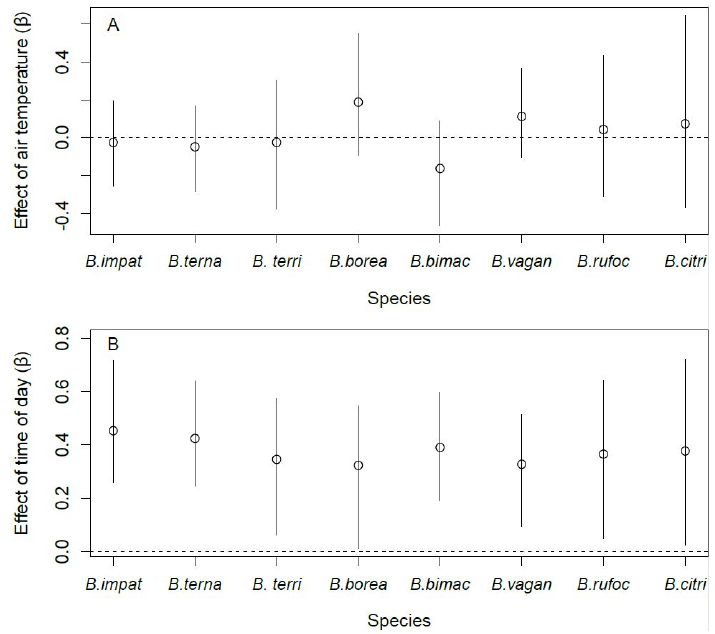
Figure 5. Effect of air temperature ( A ) and time of day ( B ) on the detection probability of the eight species of bumble bee queens sampled in orchards (2017–2019) in southern Québec, Canada. Error bars denote 95% Bayesian credible intervals around each estimate.